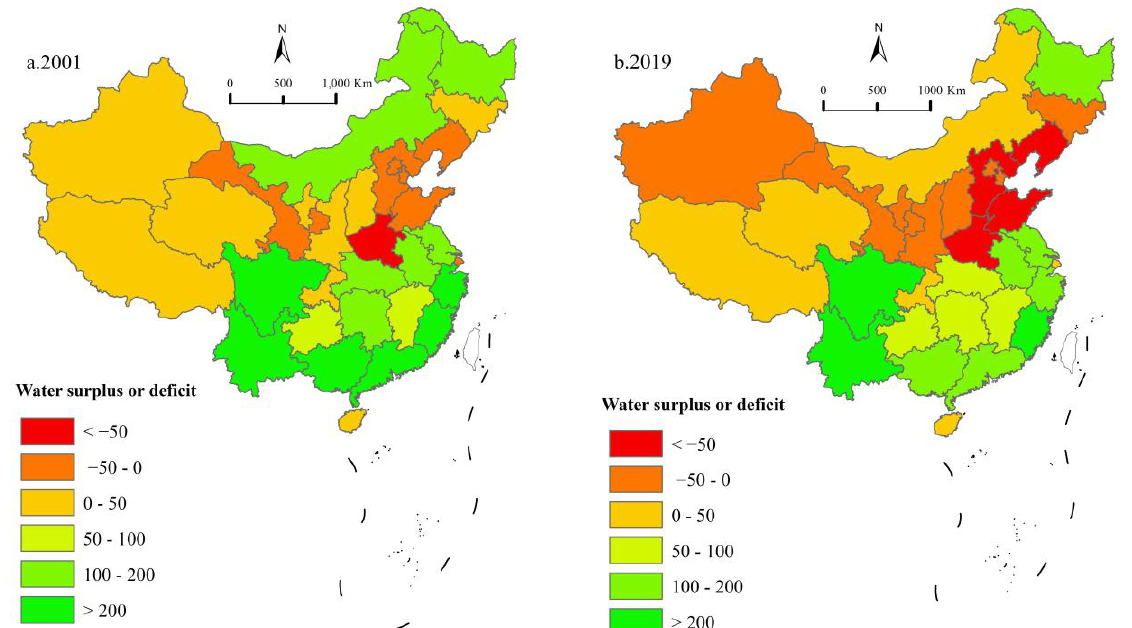
Figure 4. Water surplus and deficit of animal husbandry in 2001 and 2019.